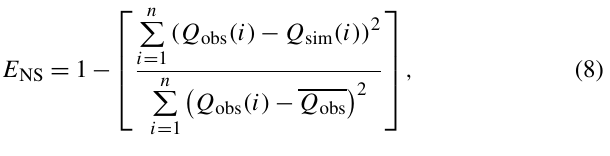
of squares of stream flow between the simulated set and